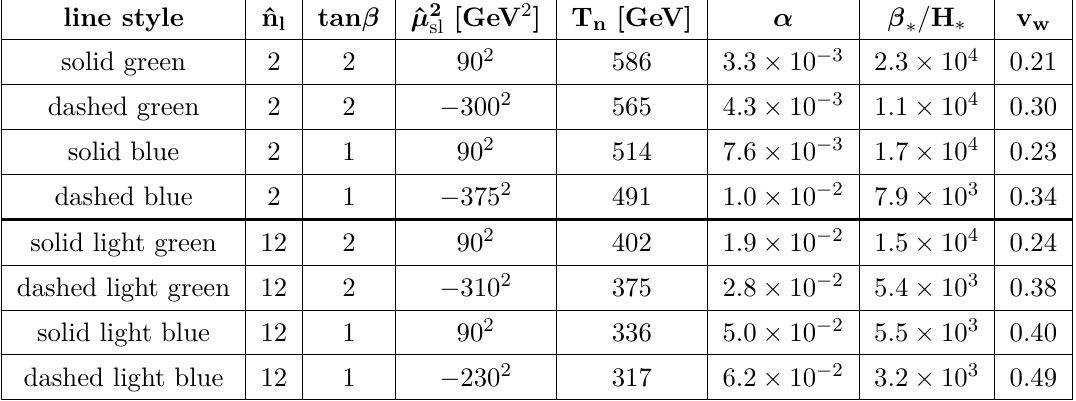
Table 4. Test points for the SUSY TH model with light sleptons and large twin lepton Yukawa couplings. We have considered two scenarios — one with a single twin lepton with enhanced Yukawa and right-handed slepton ( ˆ n sl = 2 ) and another, where all Yukawas of charged lepton twins are big and sleptons with both chiralities are active ( ˆ n sl = 12 ). We fix ˜ y l = 3 since we have numerically verified that in all considered points the GW signal is strongest for the largest ˜ y l . The remaining parameters are fixed at λ = 1 , ρ = 0 , f 0 = 4 v A . The corresponding GW spectra are plotted